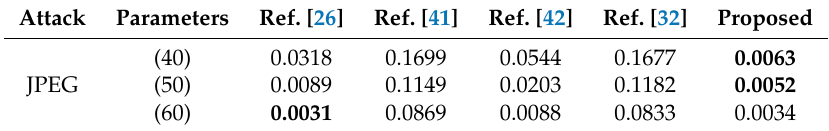
Table 3. The average BER comparison with PSNR = 42 dB under JPEG compression attacks. Attack